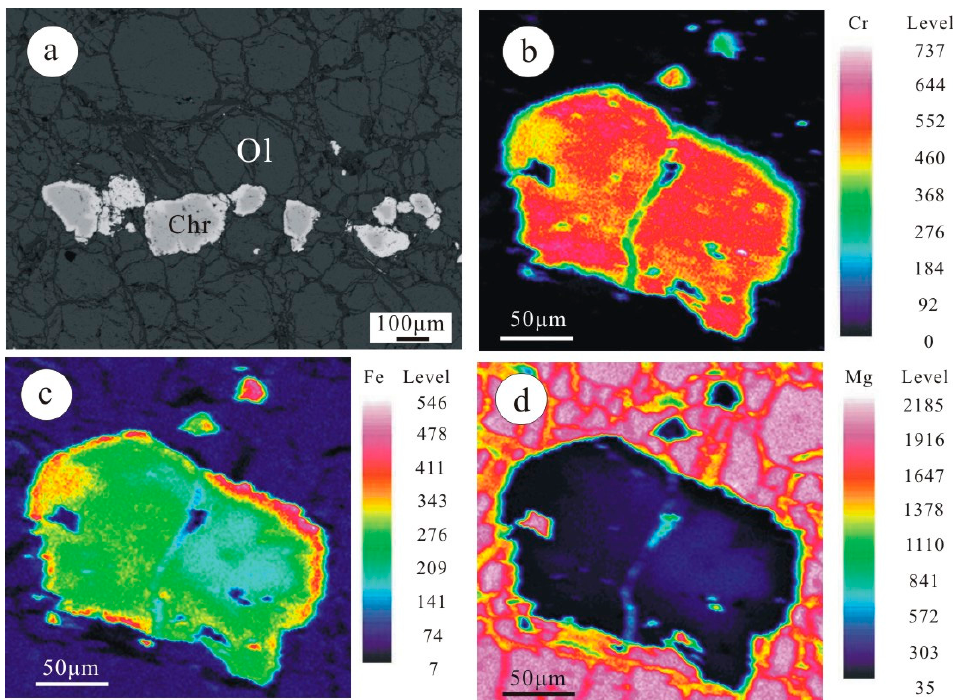
Figure 7. Backscattered image of chromite in dunite ( a ) and distribution diagrams of elements for Cr ( b ), Fe ( c ), and Mg ( d ) in chromite.